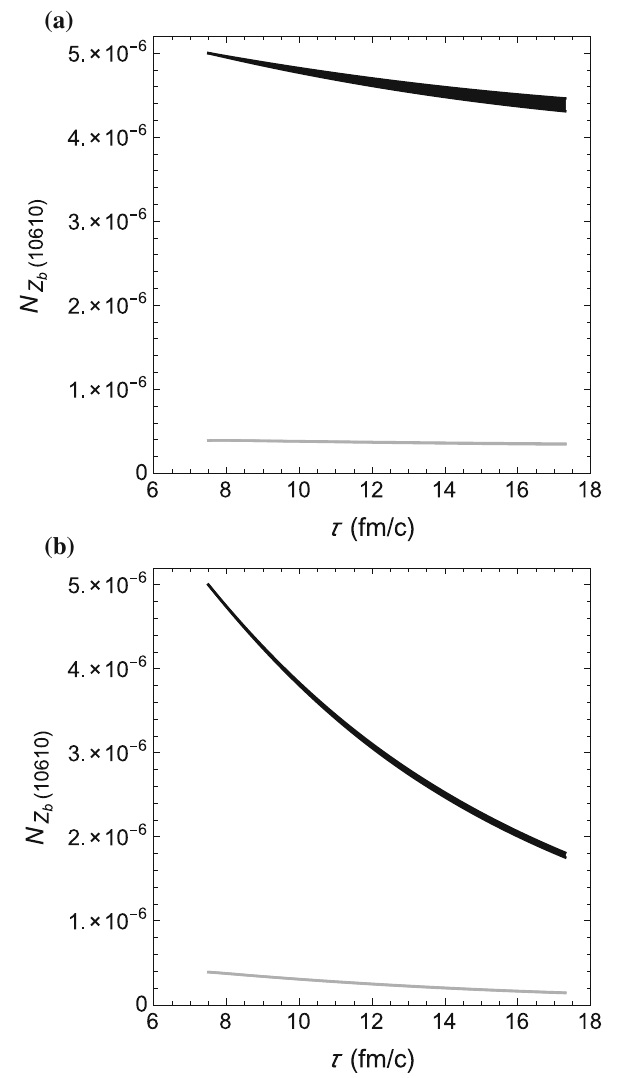
Fig. 7 a (upper panel) Time evolution of the Z b abundance as a func- √ s NN = 5 . 02 TeV. tion of the proper time in central Pb-Pb collisions at Dark and light shaded bands represent the evolution with the number of Z b ’s produced at the end of the quark–gluon plasma phase calcu- lated using statistical and four-quark coalescence models, respectively. b (lower panel) Same as a but including the decay of the Z